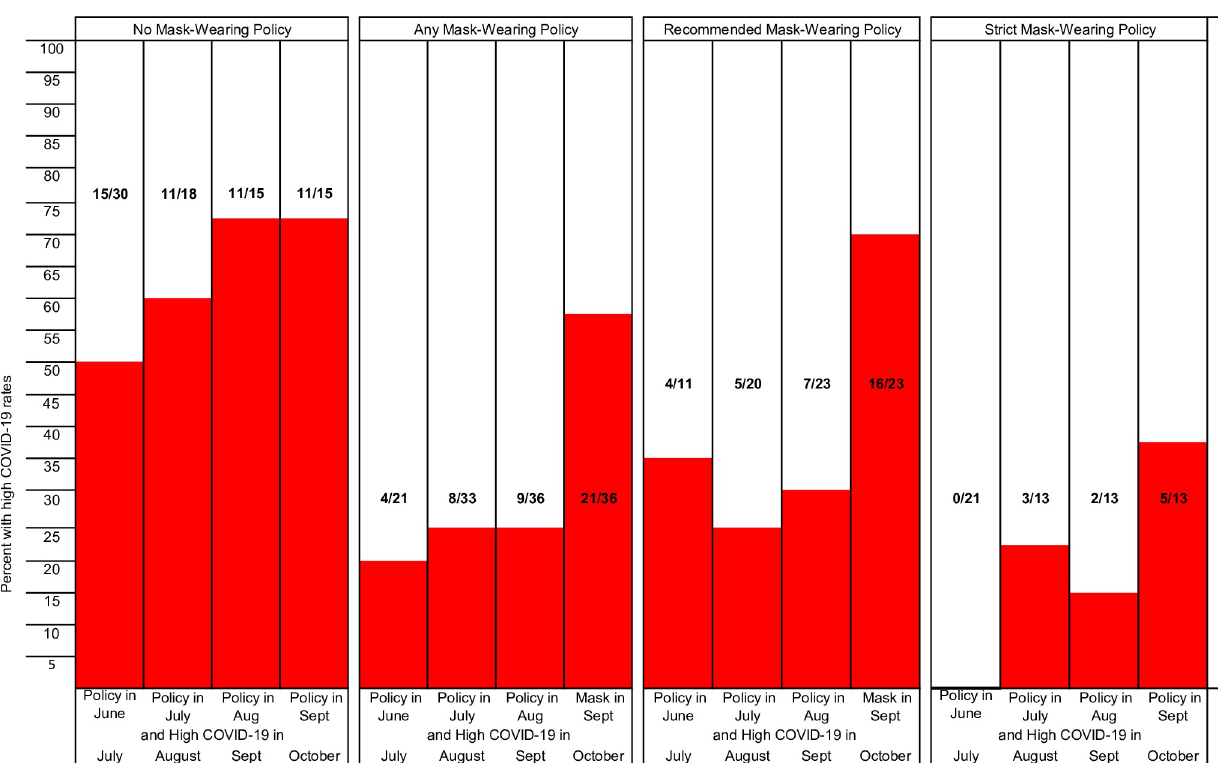
Fig 2. Proportion of states with high COVID-19 rates among those no, any, strict, and recommended mask wearing policy in the preceding month.